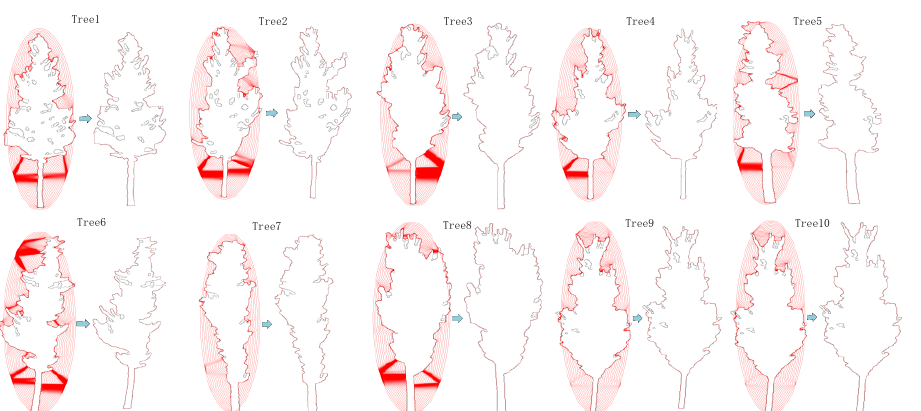
Figure 10. Convergence processes and results of Snake curves.